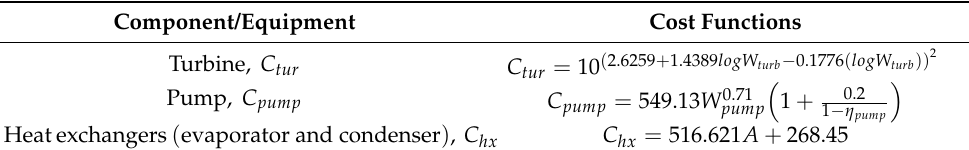
Table 3. Cost functions for the components of the Rankine cycle in